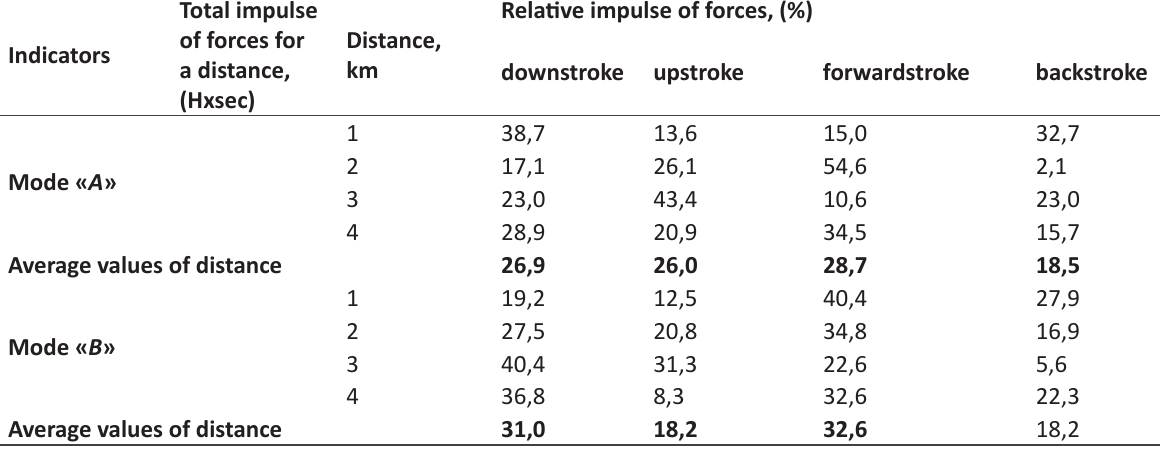
Table 2 . Dynamics of indicators of relative use of efforts in a pedalling cycle during passing a 4 km distance, (X±m)